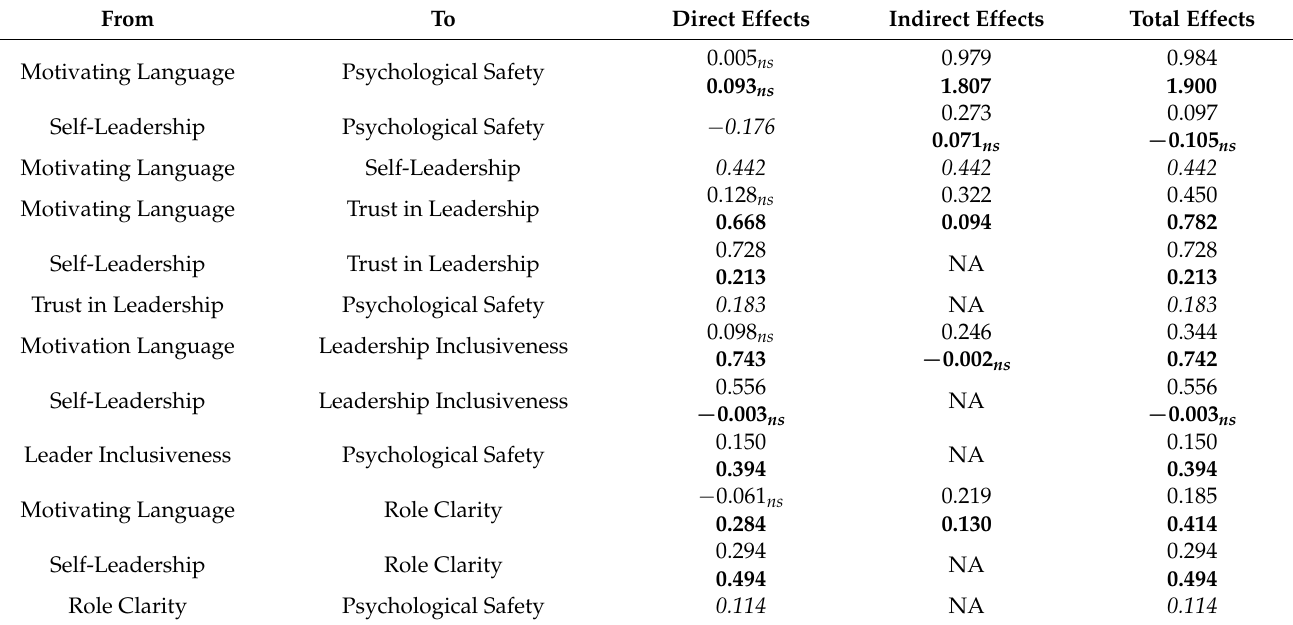
Table Notes: (1) When path differences exist between India and the USA, normal text denotes paths in India and bold text denotes paths in the USA. Paths appear in italics when no significant differences exist between nations. (2) The subscript ns indicates a non-significant path. Table 6. Reduced Model Without Motivating Language.